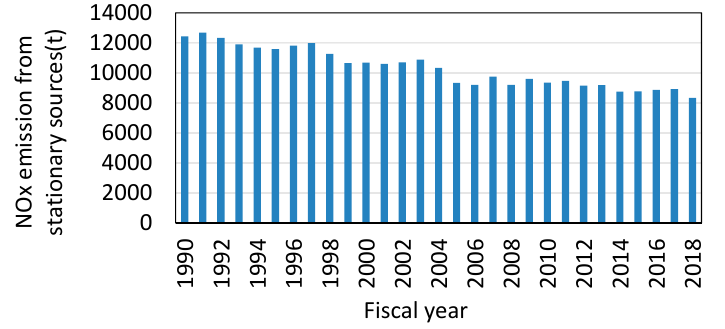
Figure 15. Trend in the emissions of NOx from factories and workplaces. NOx emissions: reported figures for annual NOx emissions from factories and workplaces with facilities that emit soot and smoke, as specified by the Air Pollution Control